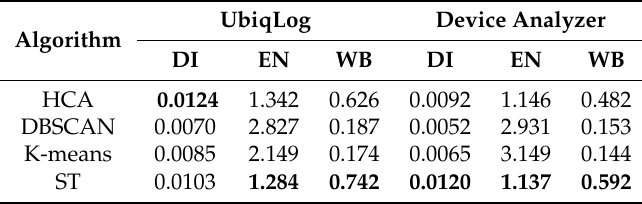
Table 5. Quality comparison between ST and representative clustering methods in two datasets. UbiqLog Algorithm